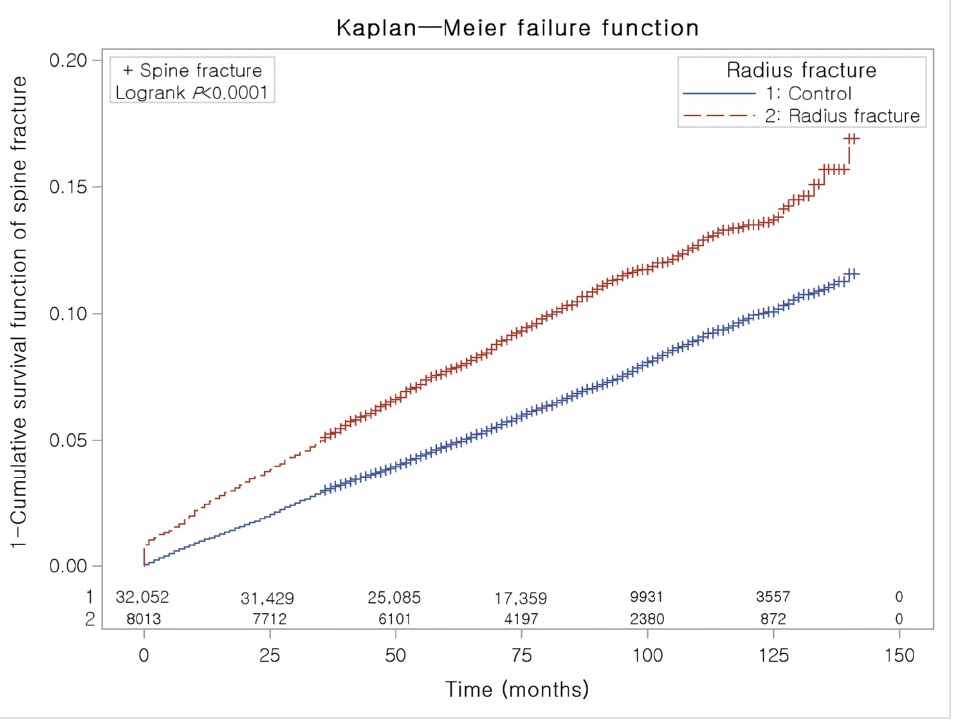
Figure 3. A Kaplan–Meier analysis of the incidences of spinal fracture in the distal radius fracture group and the control group. During the follow-up period, the cumulative incidence of spinal fracture in the distal radius fracture group was significantly higher than that in the control group. Table 2. Crude and adjusted hazard ratios (95% confidence interval) of distal radius fracture for hip and spinal fracture in total participants (n = 40,075). Fracture